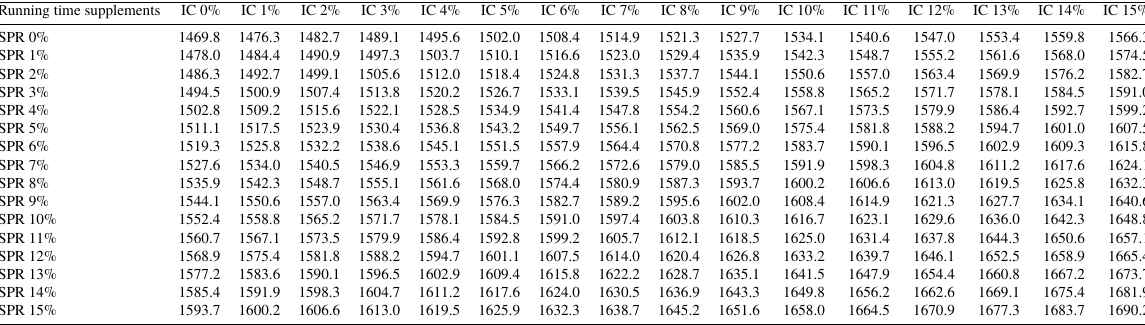
Table 11: Total running time (s) per IC-SPR cycle for different running time supplements for the real-world case study Ah-Nm.